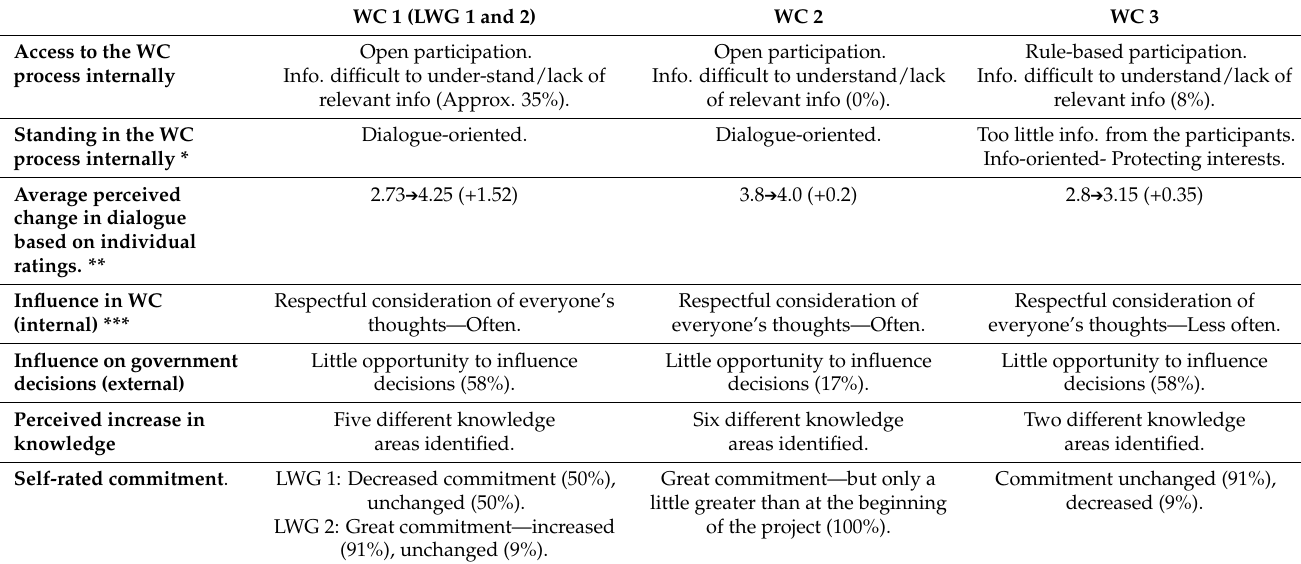
Table 4. Process outcomes related to trust (in terms of access, standing, influence), constructive dialogue (part of standing), commitment, and knowledge